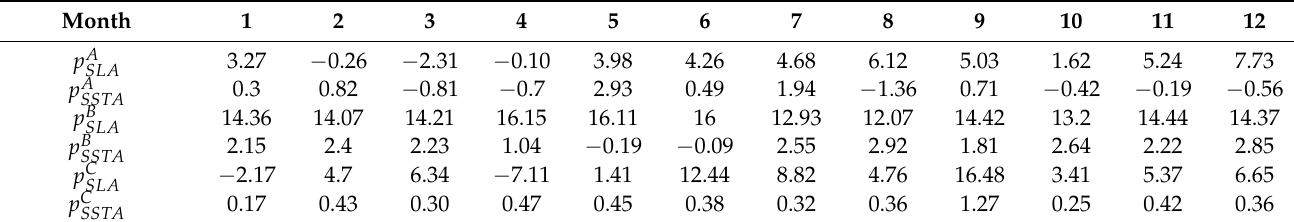
Table 1. Sensitivity of RMSE to SLA I and SSTA I .